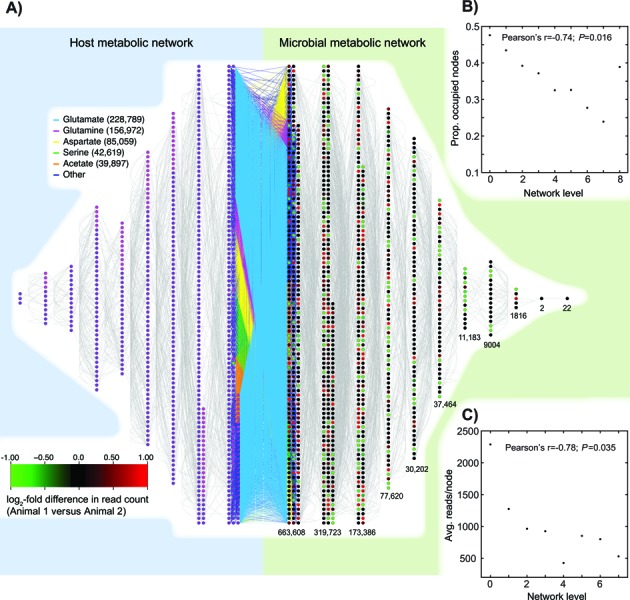
Structure of the metabolic network induced by the microbiome of the bovine rumen. (A) Interface of the host (left) and microbial (right) metabolite networks. Nodes (circles) are reactions: two nodes are linked by an edge if they share a metabolite (gray lines, currency metabolites were excluded at a stringency of 25—e.g., N25 see ‘Materials and Methods’ section). The interface of the two networks is illustrated in the center. The five most common interface metabolites are shown in color; all other interface metabolites are blue. Host/microbial reactions that employ an interface metabolite are shown as the two closest layers: subsequent layers are removed from this interface based on their nearest metabolites to that interface (‘Results’ section). Microbial nodes are color-coded based on the log2 difference in the normalized number of read pairs mapped for animal 1 versus animal 2: thus green nodes represent over-abundance in animal 2 and red ones in animal 1. Only nodes with a binomial probability of P ≤ 0.01 of having an equal numbers of reads are shown with fold-differences (all others shown in black). Numbers under each layer give the total number of read pairs mapped to that layer. Host nodes are shown in purple (reactions annotated in humans), magenta (reactions annotated in cattle) and green (the added pseudo-reaction that allows the use of butyrate; ‘Materials and Methods’ section). (B) The proportion of nodes in each microbial layer with a mapped read pair is inversely correlated with the distance from the host metabolic network (see ‘Results’ section). (C) The number of mapped read pairs per node is also inversely correlated with the distance to the host metabolic network.